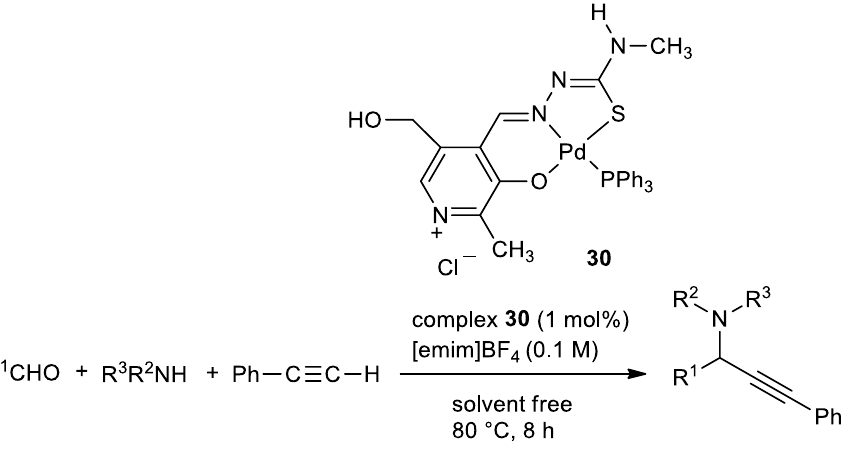
Table 3. Sonogashira reactions catalysed by thiosemicarbazone complexes: representative conditions and yields 1